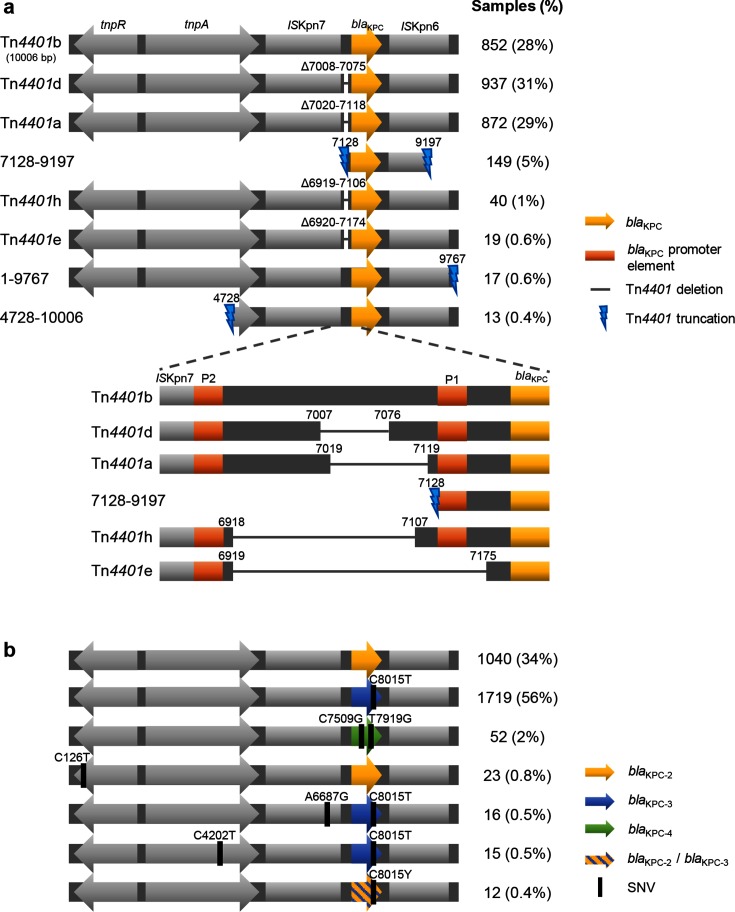
Structure of Tn4401 showing common structural variants (a) and SNVs (b). Only variants found in at least ten samples are shown. For simplicity, SNV variants are all illustrated within a Tn4401b structural background.